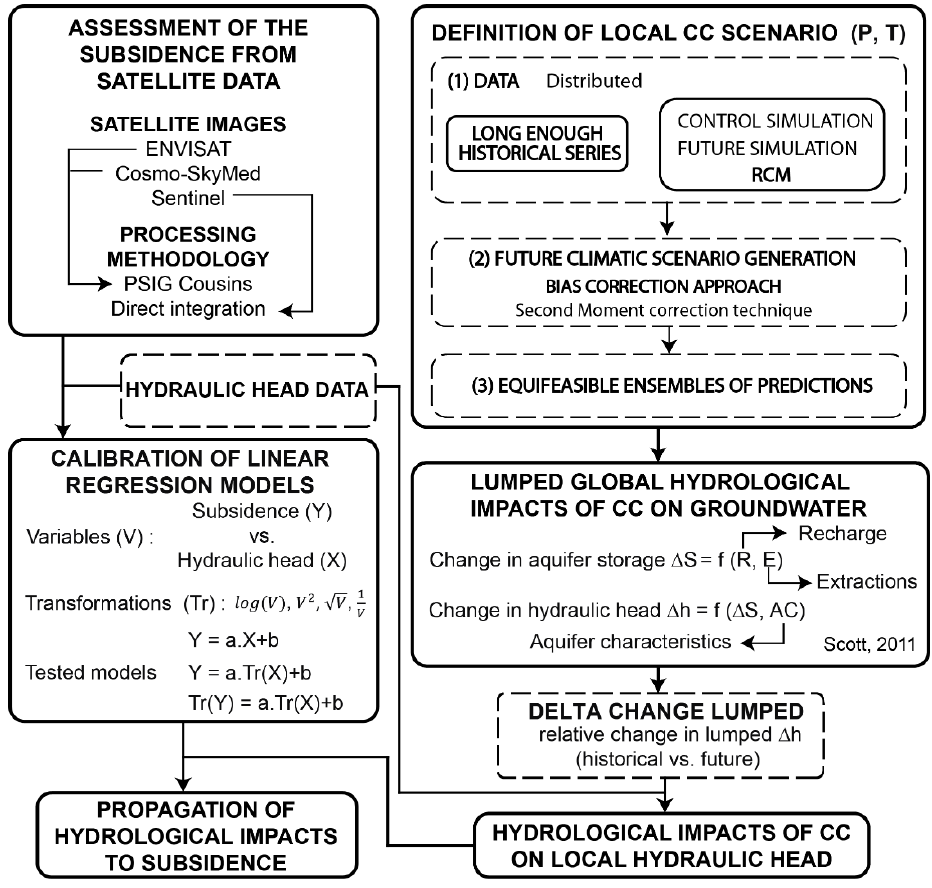
Figure 2. Flow chart of the proposed methodology.